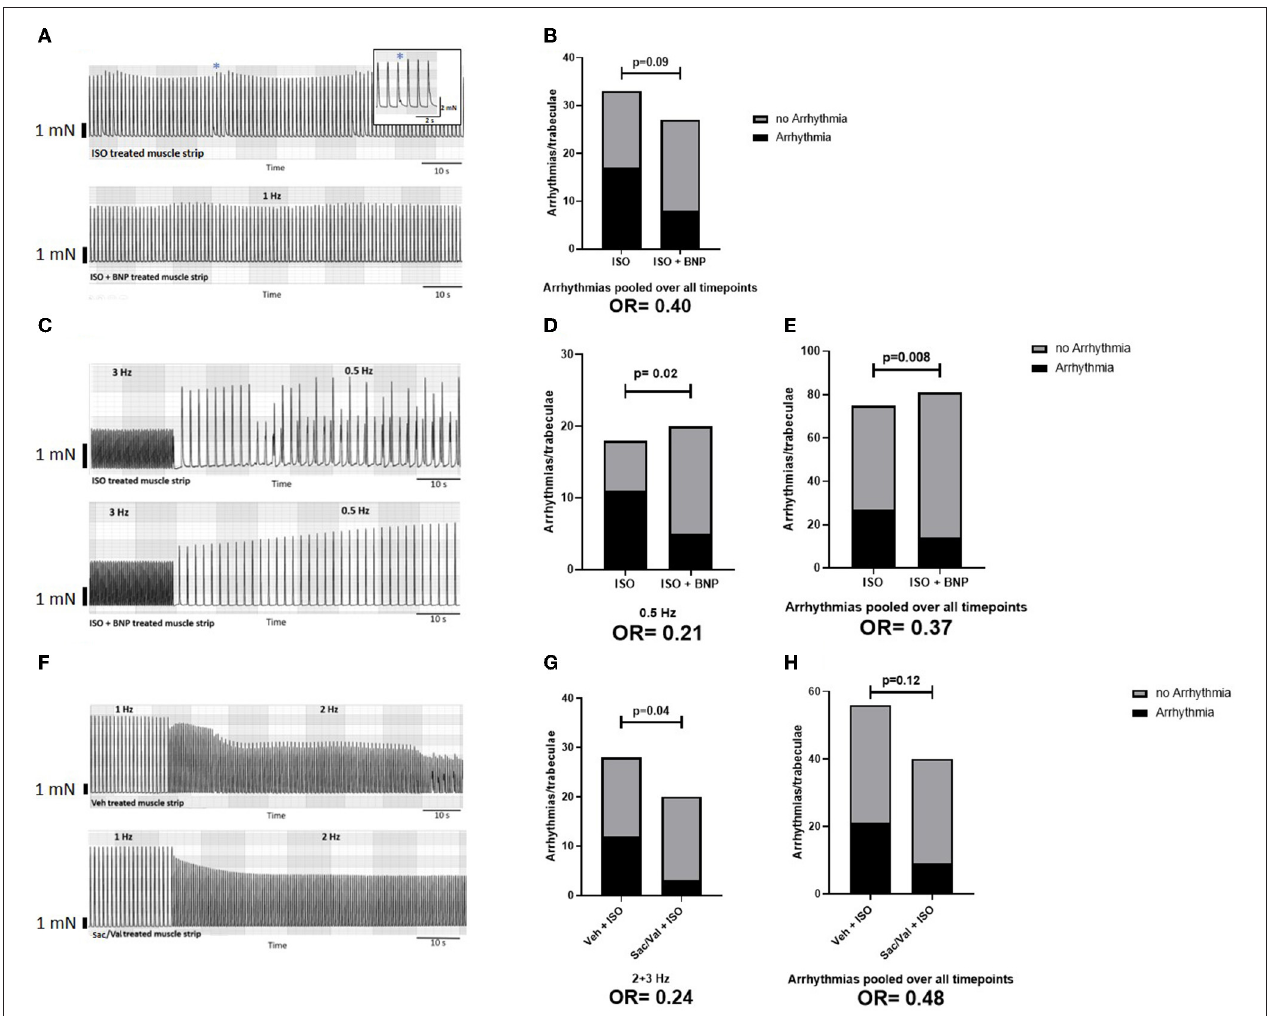
FIGURE 3 | Effect of BNP and Sac/Val on atrial arrhythmogenesis. (A) Representative traces of a protocol with constant stimulation at 1Hz in strips treated with ISO ± BNP; the overall effect of BNP treatment on arrhythmogenesis in this protocol is shown in (B) . For this analysis, three time intervals (25–30, 45–50, and 65–70min) after ISO have been screened for arrhythmias. (C) Example traces for muscle strips treated with ISO ± BNP during the switch from 3Hz to 0.5Hz stimulation frequency in a “frequency-variation protocol” protocol. The effects of BNP on arrhythmogenesis at 0.5Hz (D) and pooled over all time points (E) are shown. For this analysis, the arrhythmias at 1Hz (10min) and 2, 3, and 0.5Hz (each 5min) have been included Finally, example traces of muscle strips treated with a vehicle (DMSO) or Sac/Val at the transition between 1 and 2Hz stimulation frequency are shown in (F) , with the effects of Sac/Val treatment on arrhythmias at higher stimulation frequencies in (G) and the overall effect on arrhythmia in (H) . For this analysis, the arrhythmias at 1Hz (10min) and 2, 3, and 0.5Hz (each 5min) have been included. ISO, isoproterenol; BNP, brain natriuretic peptide; Veh, vehicle (DSMO); Sac, sacubitrilat; Val,